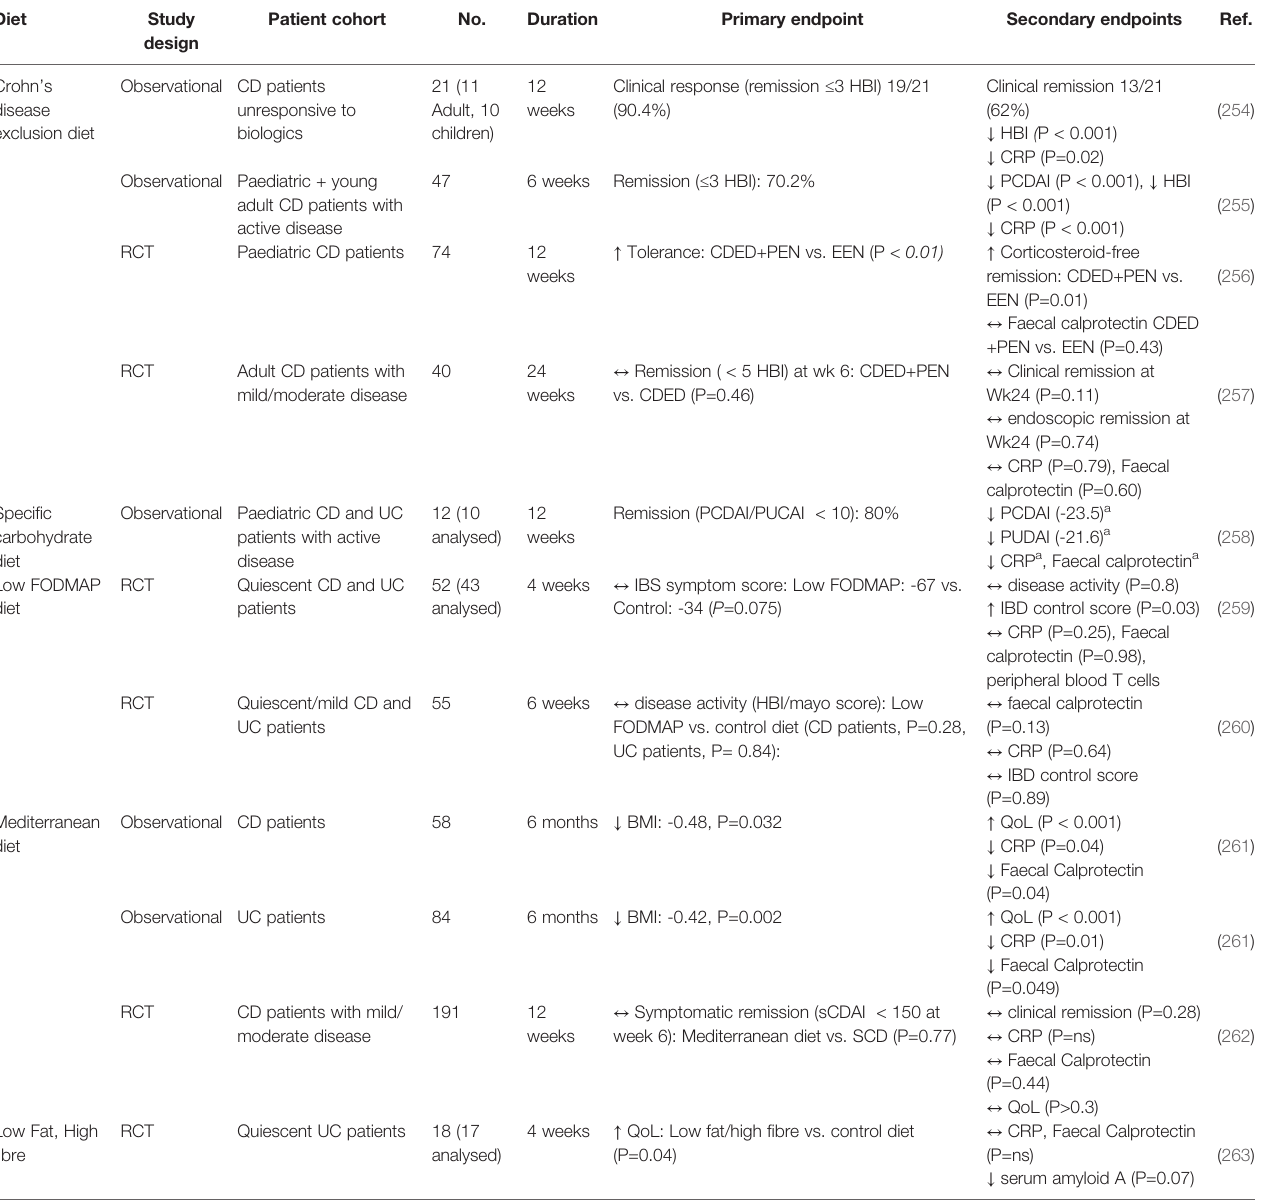
TABLE 2 | Dietary randomized control trials to treat In fl ammatory bowel disease. Diet Study design